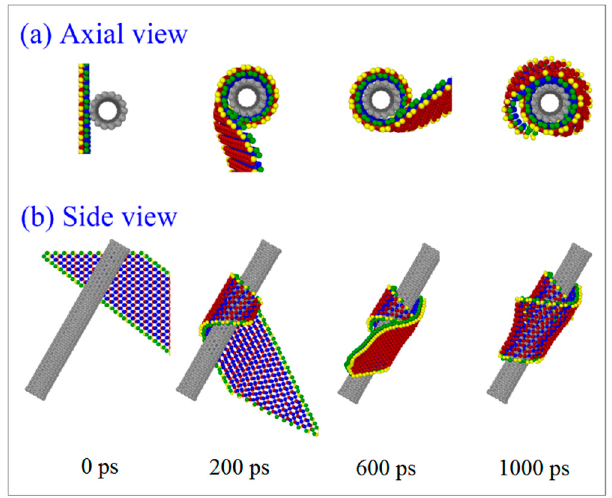
Figure 5. Snapshots in the winding process of BP ribbons with the CNT (7, 7) system with L y = 0 nm, α = − 30°. ( a ) Axial view. ( b ) Side view.